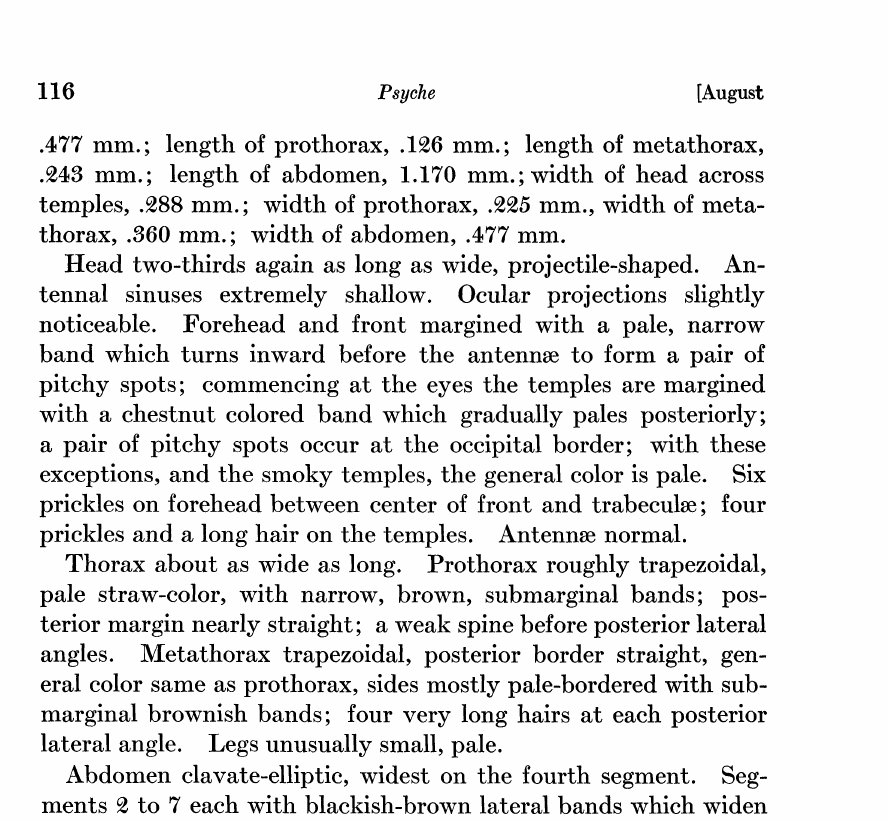
. Fig. 1. Male of Lipeurus aberrans sp. nov. Male of Lipeurus lineatus sp.